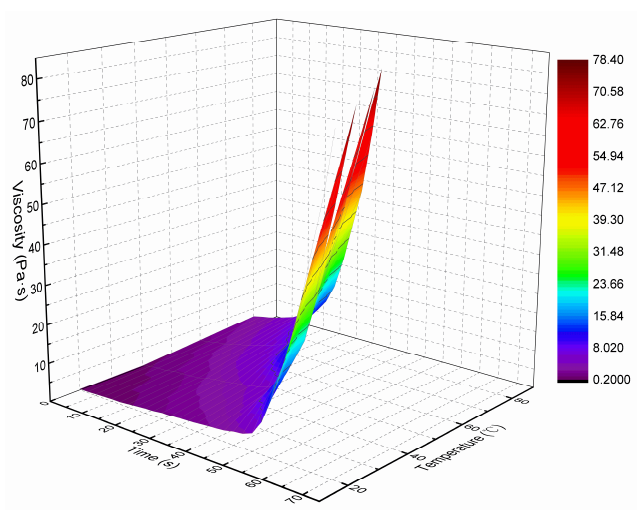
Figure 18. The relationship of viscosity-temperature-time of the cement-sodium silicate slurry.